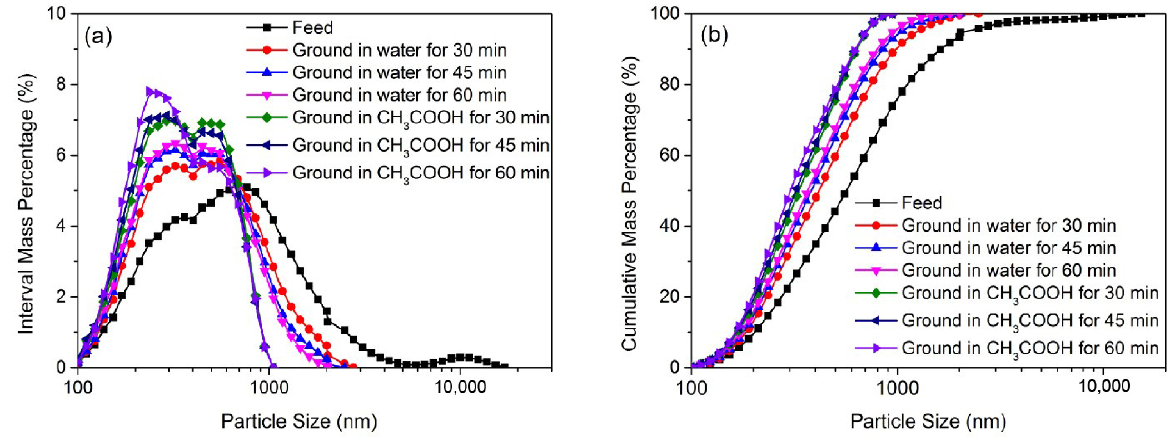
Figure 5. The PSD of ZnO particles ground in water or in a CH 3 COOH solution at a low concentration of 0.010 mol/L for different lengths of time. ( a ) the interval mass distribution of ZnO particles; ( b ) the cumulative mass distribution of ZnO particles. Table 4. The d 50 , n and sphericity values of ZnO particles ground in water or in a CH 3 COOH solution at a low concentration of 0.010 mol/L for di ff erent lengths of time.